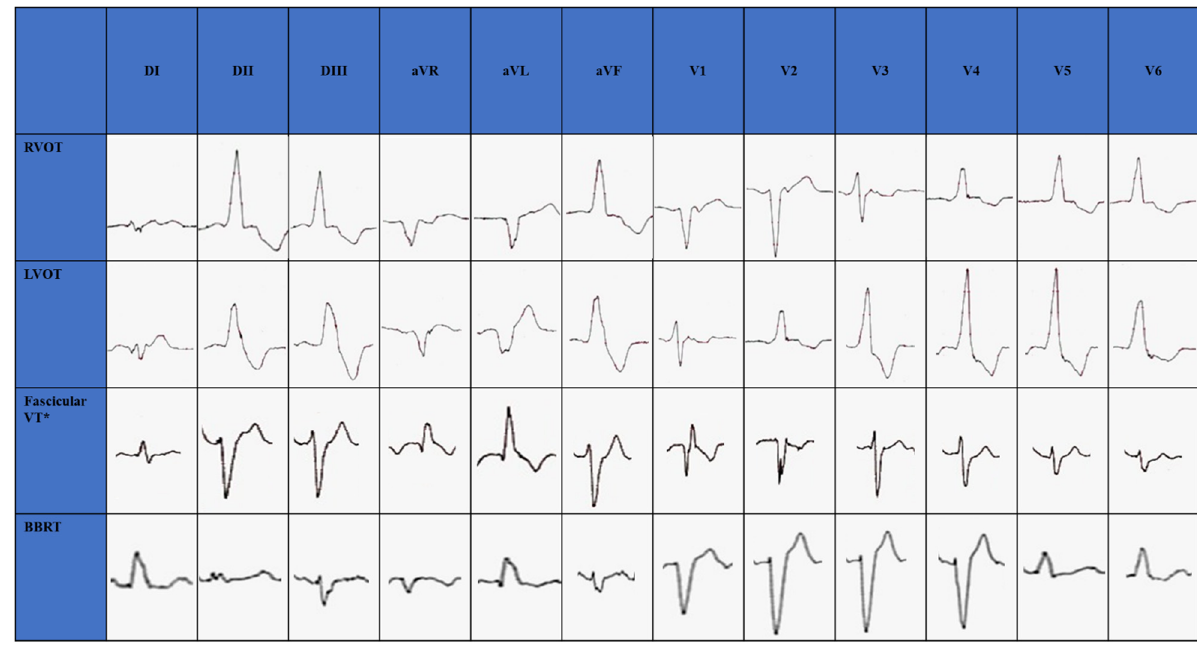
Figure 1. Electrocardiographic morphology of RVOT, LVOT, Fascicular VT and BBRT. Among non ‐ outflow tract IVAs, LV papillary muscles are a common site of origin.